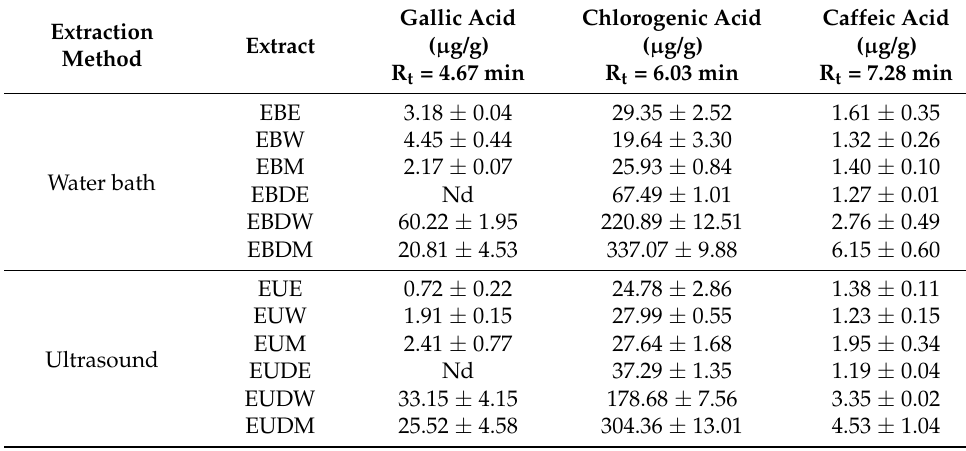
Table 3. Profile of major phenolic compounds from coffee husk extracts.